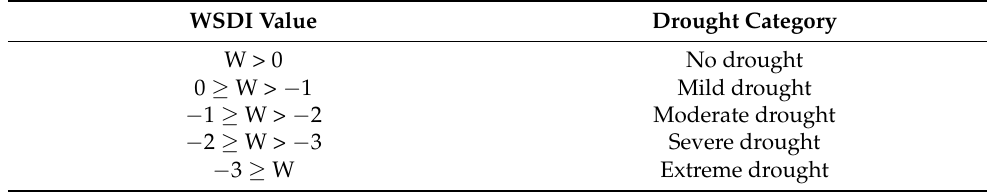
Table 1. Characterization of drought intensity by WSDI.